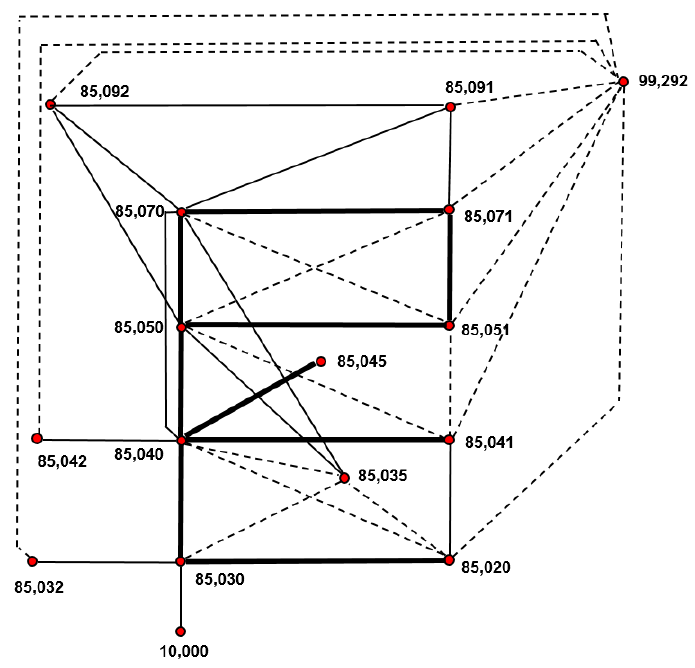
Figure 4. The 16 nodes model.